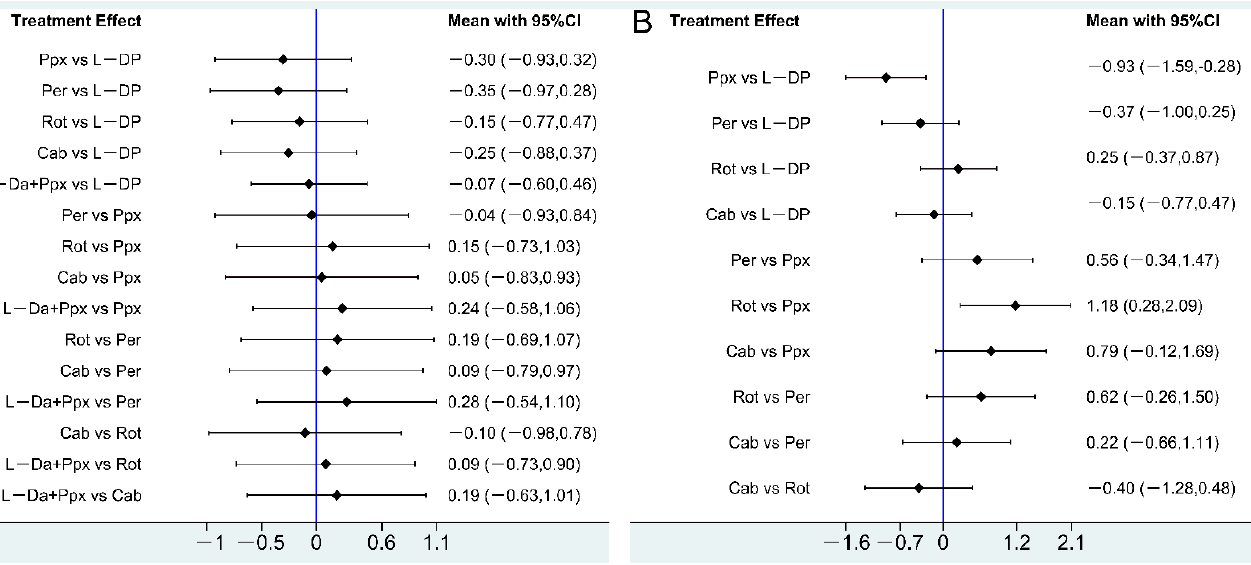
Figure 3. Forest plots of pairwise comparison. ( A ) Forest plots of pairwise comparison of this NMA for all included drugs on letter fluency; ( B ) forest plots of pairwise comparison of this NMA for all included drugs on semantic fluency. L—DP, Levodopa; L—DP + Ppx, Levodopa combined with pramipexole; Per, Pergolide; Ppx, Pramipexole; Rot, Rotigotine; Cab, Cabergoline.